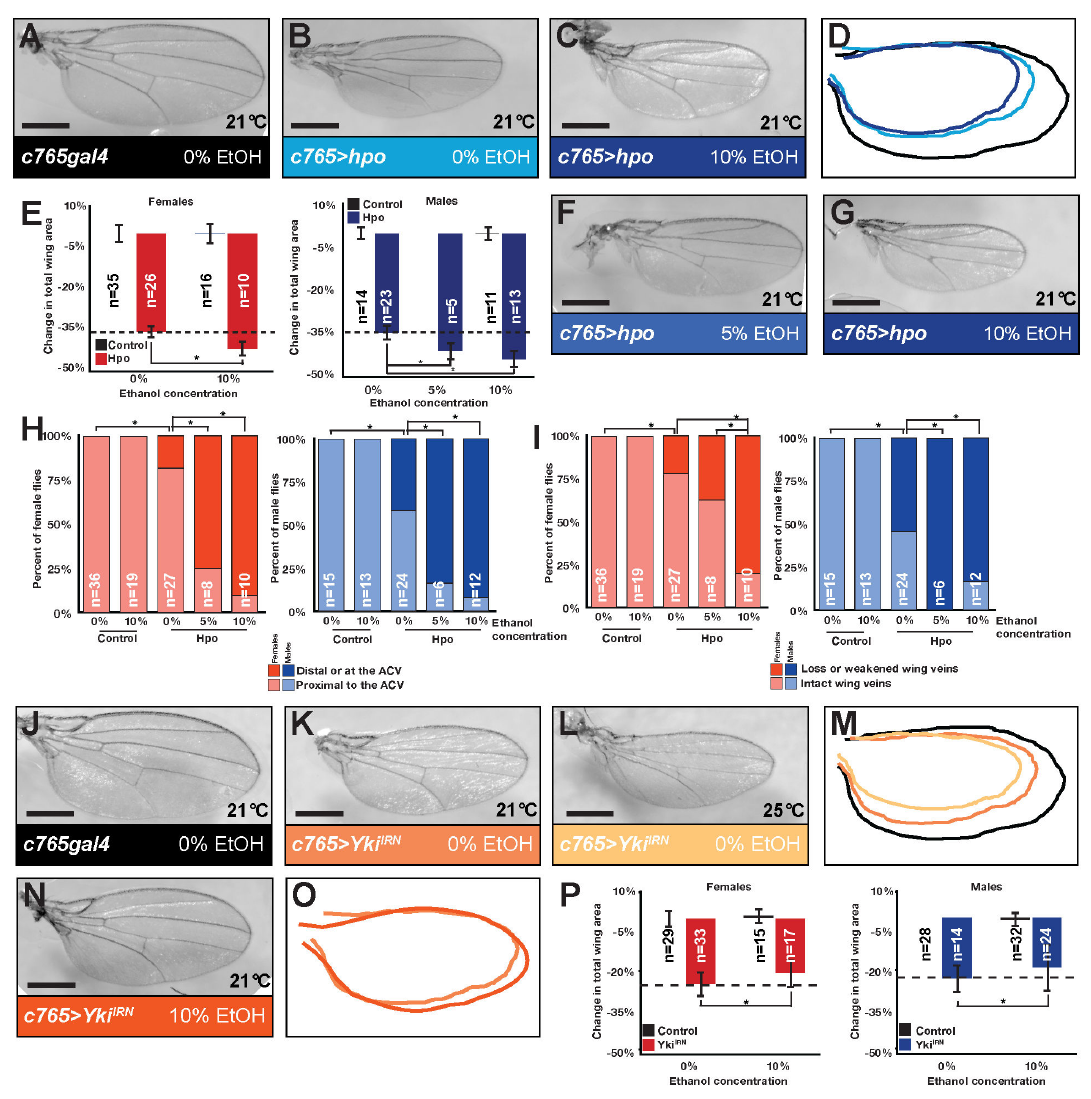
Figure 3. Ethanol promotes Hippo signaling in Drosophila . (A) Control wing. Representative wings over-expressing hpo reared on (B) 0% ethanol and (C) 10 % ethanol. (D) Tracings of wings in A-C. (E) Quantification of the effects of ethanol treatment on wing area (normalized to control wing treated with 0% ethanol). Significant area effects were seen at 5% in some but not all experiments. * indicates p=0.00004738091994 (males, 5%), p=0.0000003789435 (females, 10%), and p=5.50153E-11 (males, 10%). (F-G) Wings from flies reared on (F) 5% and (G) 10% ethanol showed increased patterning abnormalities. (H) Quantification of the effects of ethanol on proximal-distal positioning of the intersection of L2 and L3. Comparing control and Hpo over-expressing wings at 0% ethanol, * indicates p=0.0132429375674621 (females) and p=0.00003467107 (males). Comparing Hpo over-expressing wings at 0% to 5%, * indicates p=0.0000391195433611(females), p=0.03843393 (males). Comparing Hpo over-expressing wings at 0% to 10%, * indicates p=0.0000000059140932 (females) and p=0.000442676 (males). (I) Quantification of weakening and loss of segments within L2, L3, and L4 longitudinal veins. Comparing control and Hpo over-expressing wings at 0% ethanol, * indicates p=2.45092E-22 (females) and p=0.00000659349 (males). Comparing Hpo over-expressing wings at 0% to 5%, * indicates p=0.02424 (males). Comparing Hpo over-expressing wings at 5% to 10%, * indicates p=0.00550172 (females). Comparing Hpo over-expressing wings at 0% to 10%, * indicates p=0.00001108737(females) and p=0.04258 (males). (J) Control wing. (K-L) Representative wings undergoing RNAi to yki . Obvious wing size reduction is observed at 21°C (K) which increases at the higher temperature of 25°C. (M) Overlay of tracings of wings in J-L. (N) Representative wing undergoing RNAi to yki reared on 10% ethanol. (O) Overlay of tracings of wings in (K) and (N). (P) Quantification of the effects of ethanol treatment on wing area at 21°C (normalized to control wing treated with 0% ethanol). * indicates p=0.00433037 (females), p=0.030839921 (males). Wings shown are from females. doi: 10.1371/journal.pone.0078880.g003 PLOS ONE |